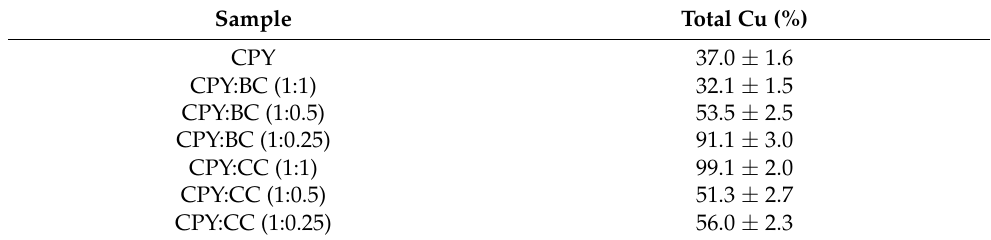
Table 3. Total extraction of Cu (%) after leaching process at 90 ◦ C for 96 h. Sample